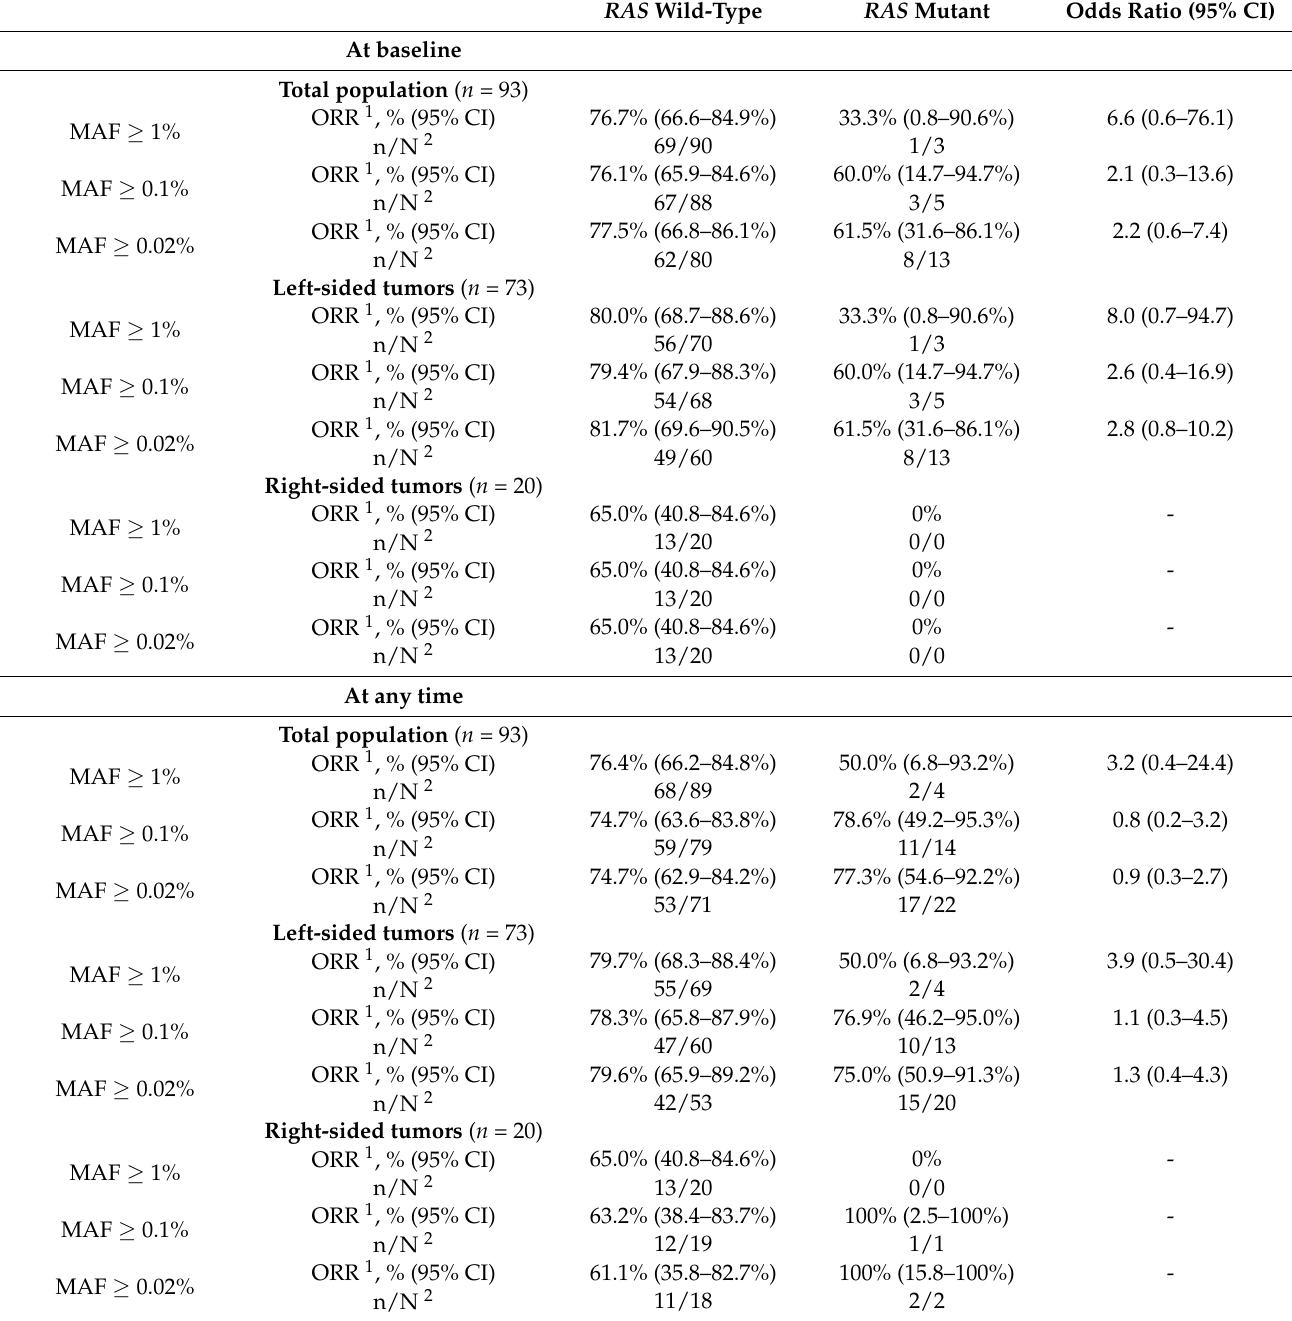
Table 3. Overall response rate according to RAS mutational status in liquid biopsy at baseline and at any time (panitumumab subpopulation, classified by primary tumor